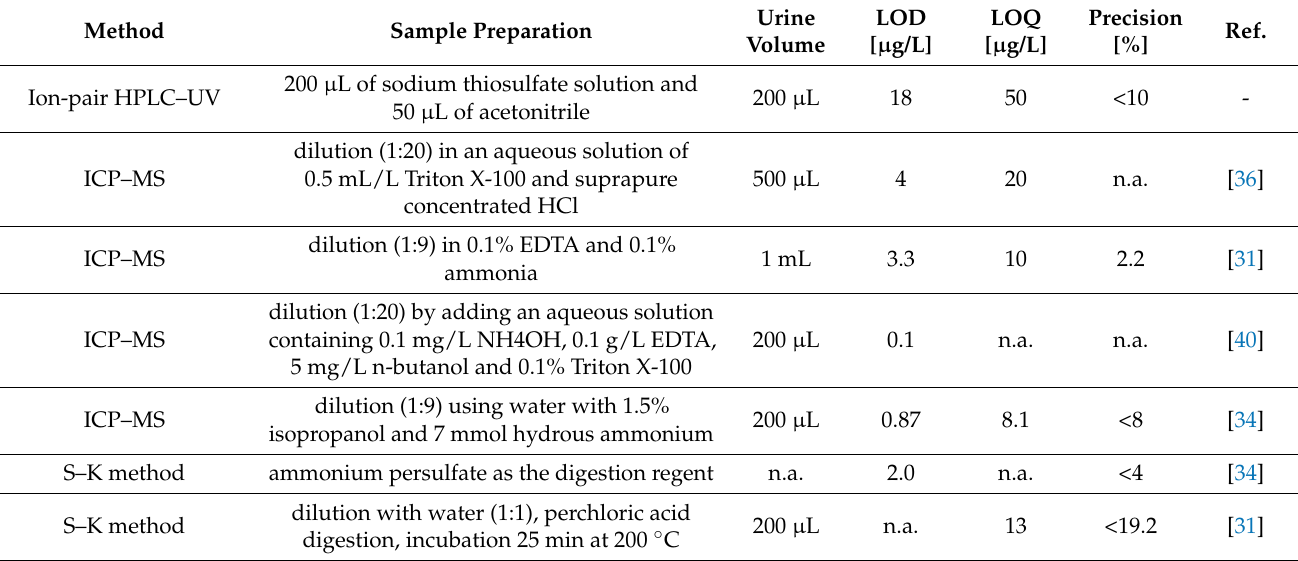
Table 4. Characteristics of the methods used for the determination of iodine in